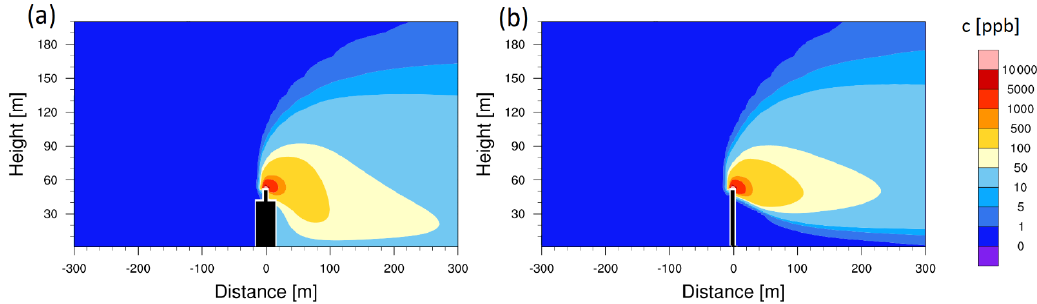
Figure 11. Visualization of the obstacle effect in MITRAS. Examples for lateral wind with v wind = 15ms − 1 , v exit = 4ms − 1 , T exh = 200 ◦ C and (cid:48) = − 1 . 2K × 100m − 1 are presented. Concentration fields are displayed with the ship pointing towards the viewer (a) and under stack- only conditions (b)